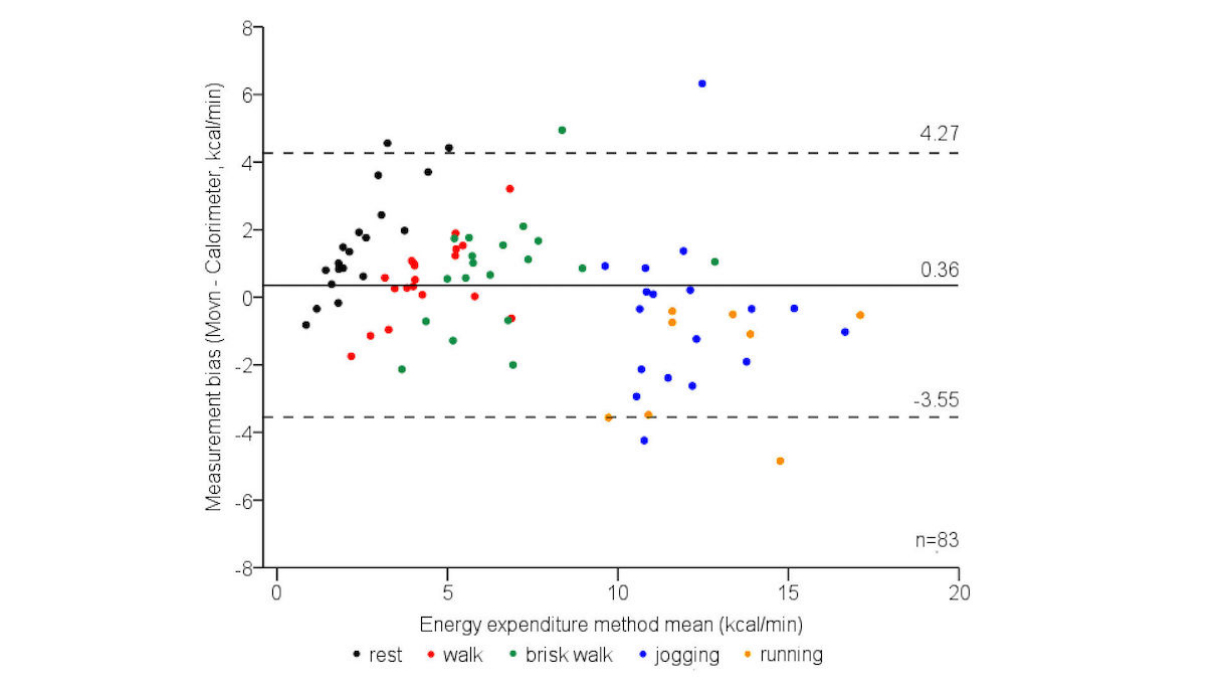
Figure 2. The 95% limits of agreement for phase 1 laboratory-based criterion energy expenditure measurement biases, categorized by activity intensity